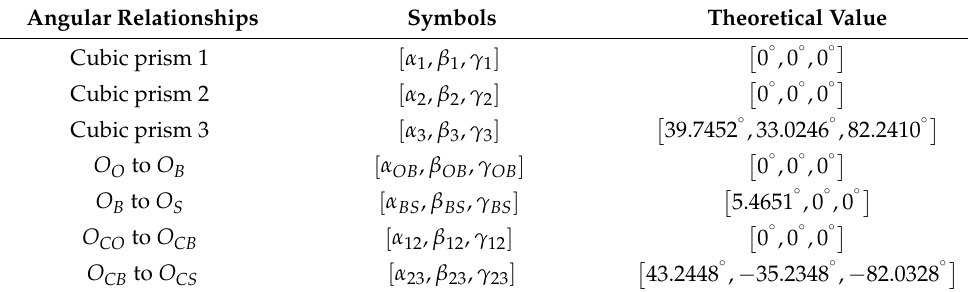
Table 3. Simulated theoretical values.